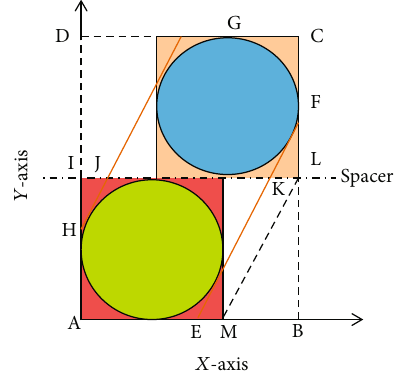
3: Reverse navigation collision geometry